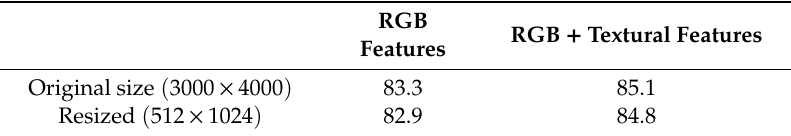
Table 3. Segmentation accuracies using